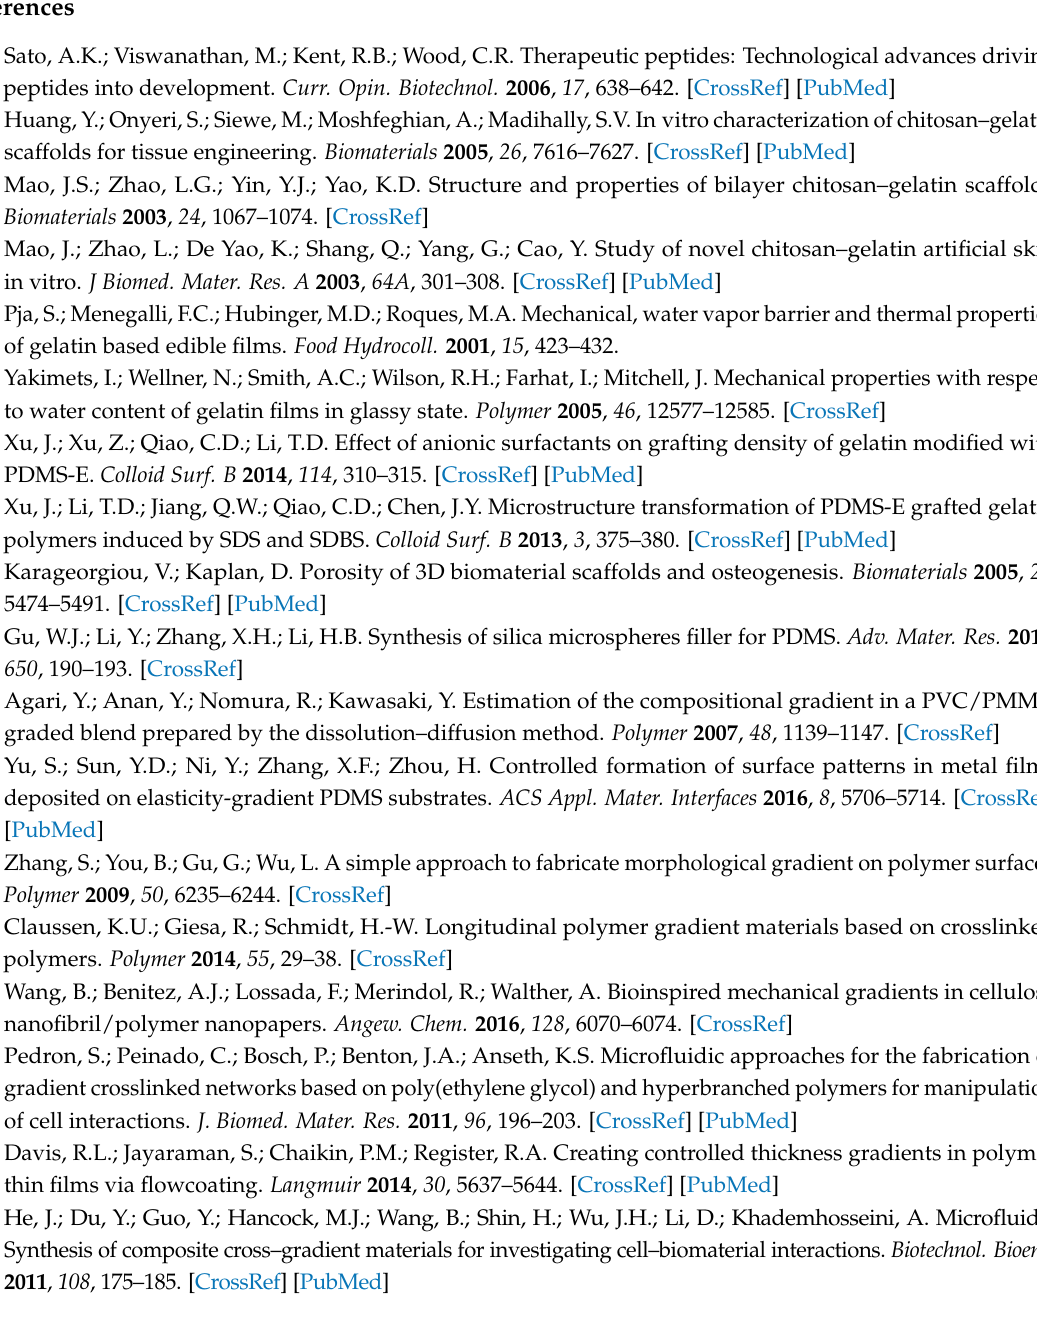
Table S1: Size distributions of PGG in ethanol/water at 0:1, 3:1, 9:1 and acetone/water at 3:1, Table S2: the statistical data of Image J, Figure S1: Optical microscopic images of PGG in ethanol/water ratios of (a) 0:1, (b) 3:1, (c) 9:1 and (d) acetone/water ratio of 3:1,Figure S2: Store-moduli and loss-moduli of the top interlayer, and bottom sections, as measured by DMA in the tensile